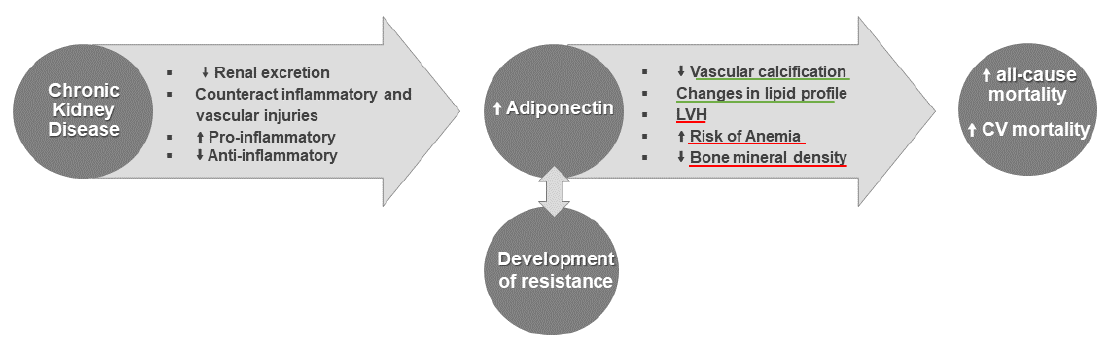
Figure 3. Schematic view of the hypotheses raised to explain the high adiponectin concentrations found in chronic kidney disease (CKD) and of the most likely effects, negative (underlined in red) and positive (underlined in green), of hyperadiponectinemia that may contribute to the high all-cause and cardiovascular (CV) mortality rates found in CKD patients. LVH, left ventricular hypertrophy. ↑ indicates increase, ↓ indicates decrease.